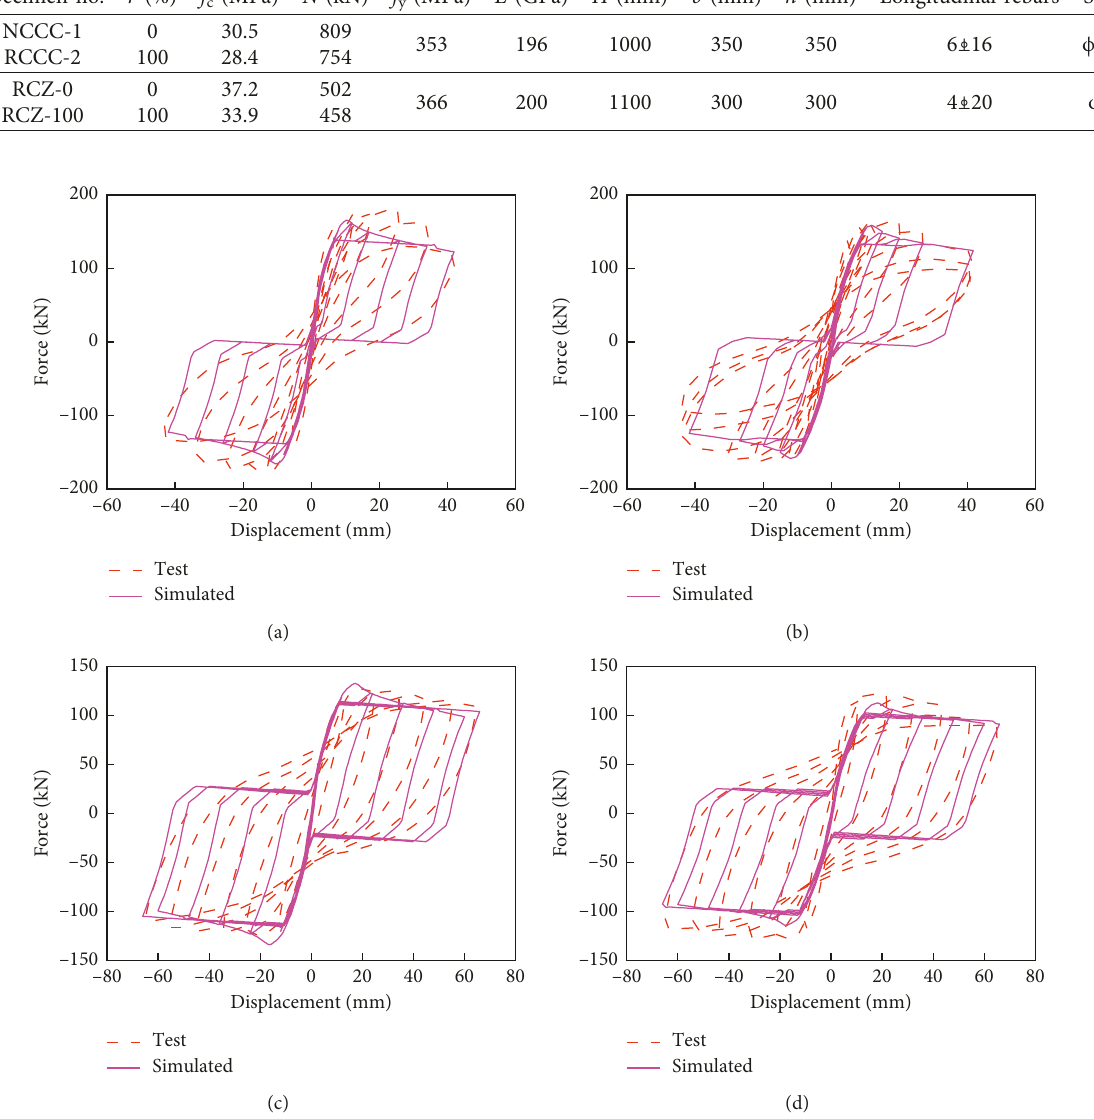
Figure 20: Nonlinear analysis of the RAC columns under cyclic loading. Specimens (a) NCCC-1 ( r � 0), (b) RCCC-2 ( r � 100%), (c) RCZ-0 ( r � 0), and (d) RCZ-100 ( r �